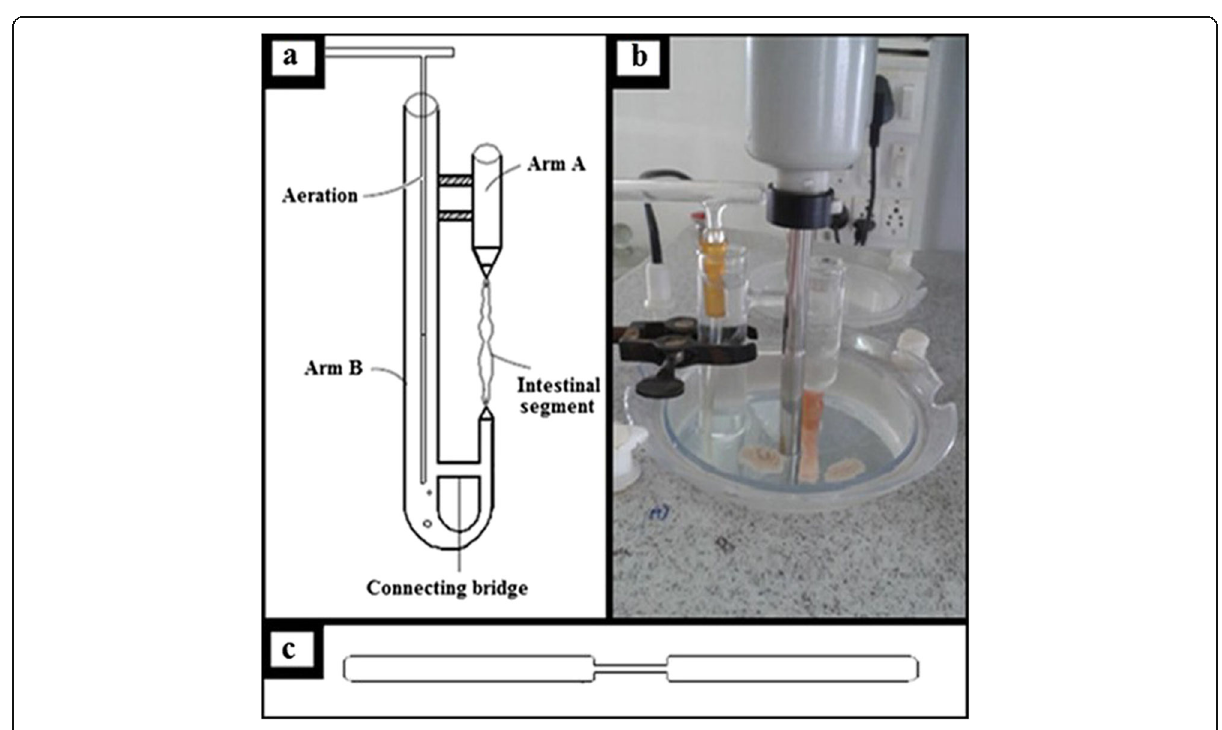
Fig. 1 Everted gut sac apparatus a U-shaped apparatus, b Assembly, c Glass